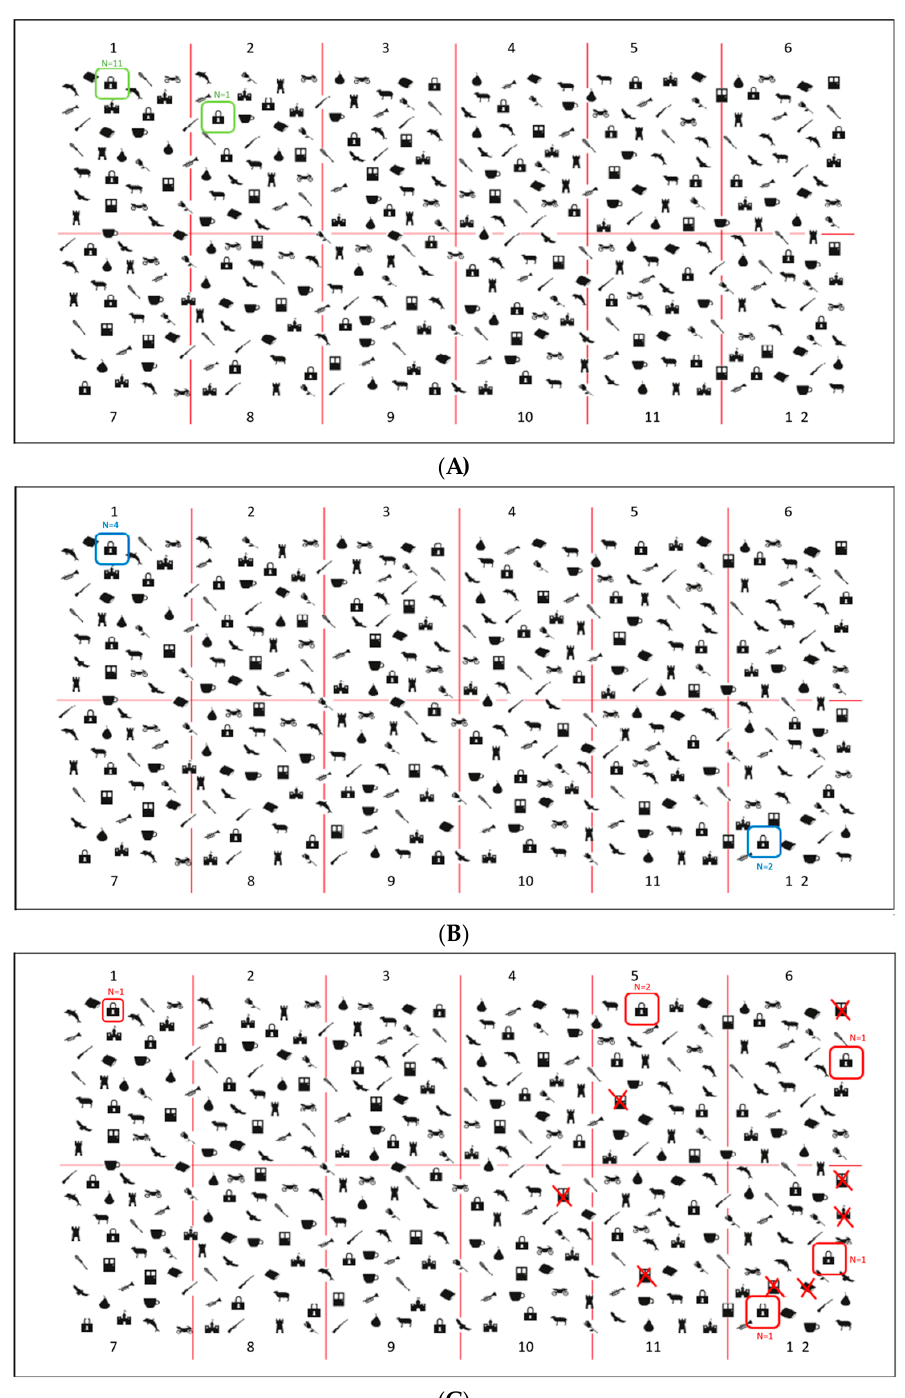
Figure 6. Padlock Test. Panel ( A ) (green square). Healthy participants starting point: 11 healthy participants started from the first upper left quadrant, 1 from the second upper left quadrant. Panel ( B ) (blue square). Patients without USN starting point: four patients without USN started from the first upper left quadrant, two from the twelfth lower right quadrant. Panel ( C ) (red square). Patients with USN starting point: two patients with USN started from the twelfth lower right quadrant, one from the sixth upper right quadrant, two from the fifth upper right quadrant, and only one from the first upper left quadrant. Other items marked with X = Other Errors; only patients with USN committed such errors Panel ( C ) .